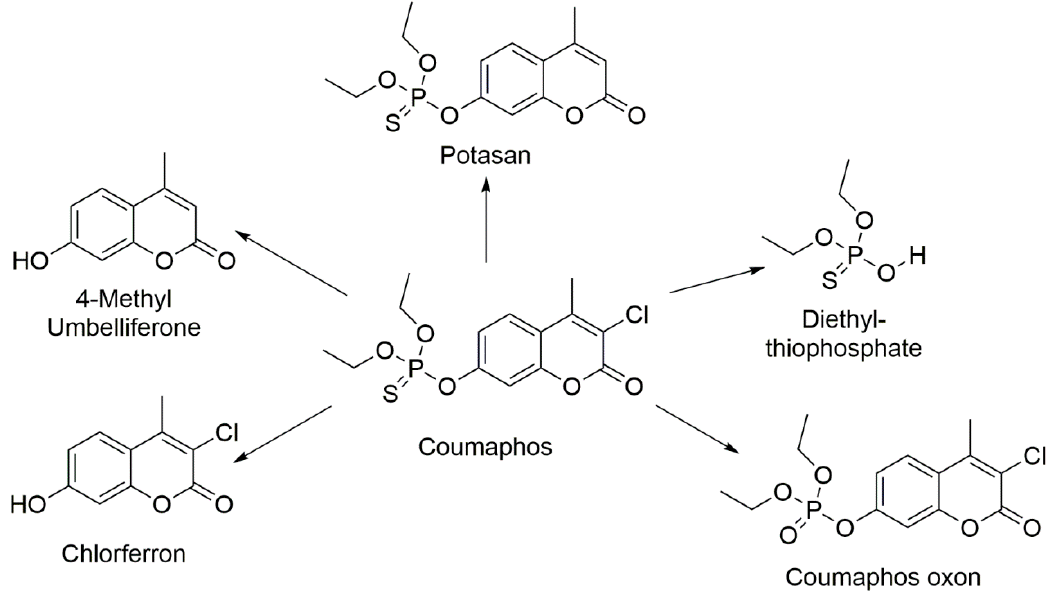
Figure 1. Coumaphos and its metabolic products.